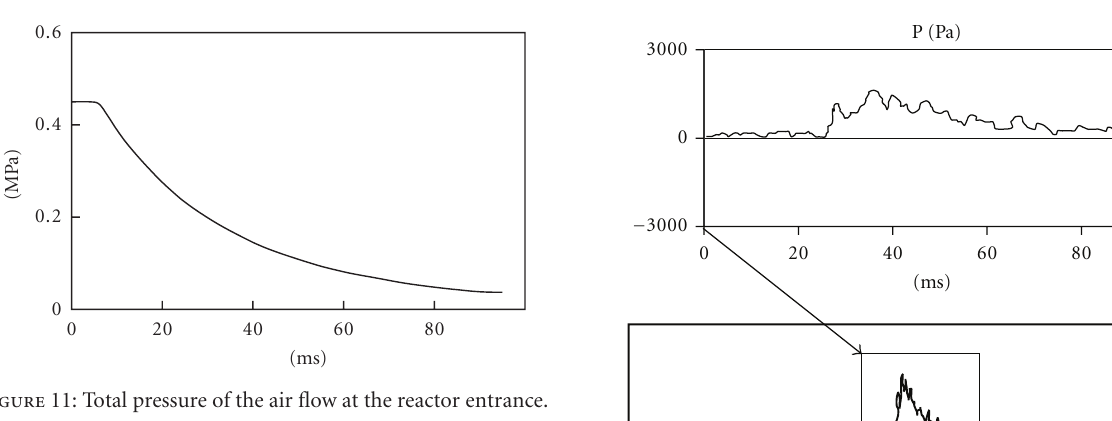
increased markedly relative to the situation with longitudinal blowing (see Figures 3 and 4). Inside the channel, in contrast to the longitudinal blowing, a uniform flow with velocity of 40 m/s is forming almost at entire length. Figure 12: Total pressure of the air flow at the reactor exit.